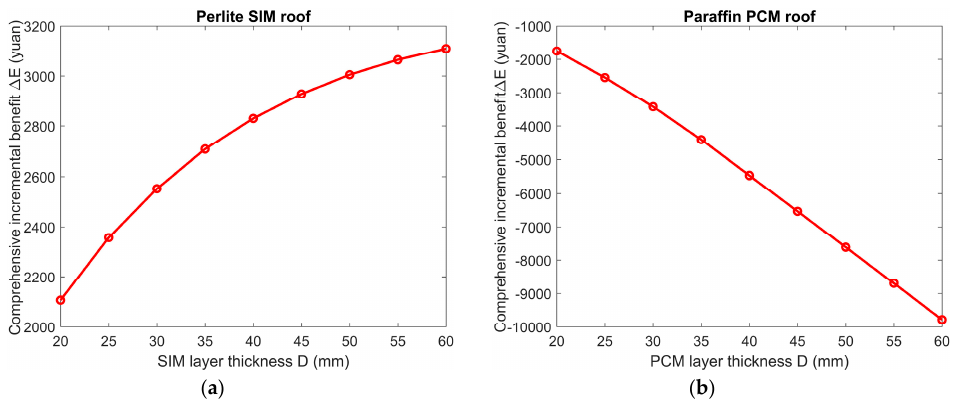
Figure 12. The comprehensive incremental benefit of a SIM roof and a PCM roof during the life cycle. Figure 11. The effect of layer thickness on the energy saving amount of PCM or SIM roofs during the winter heating season.